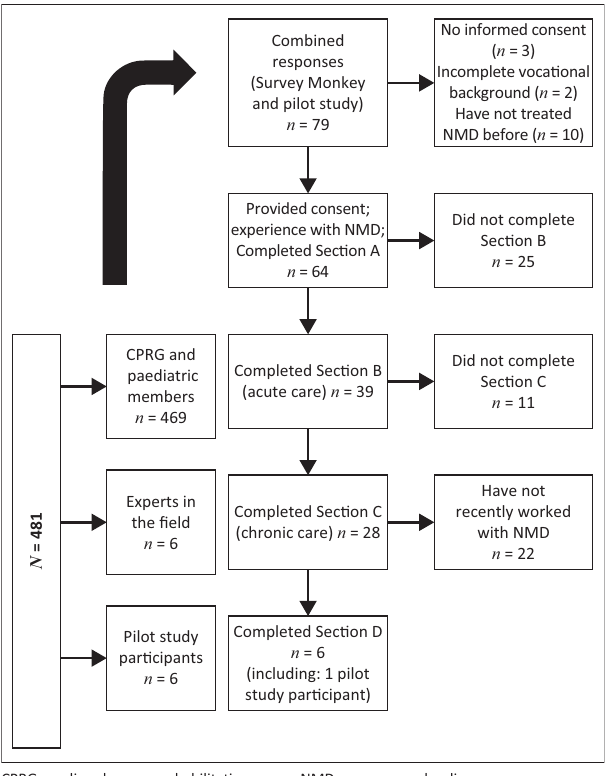
FIGURE 2: Flow chart of combined responses for pilot study participants and electronic